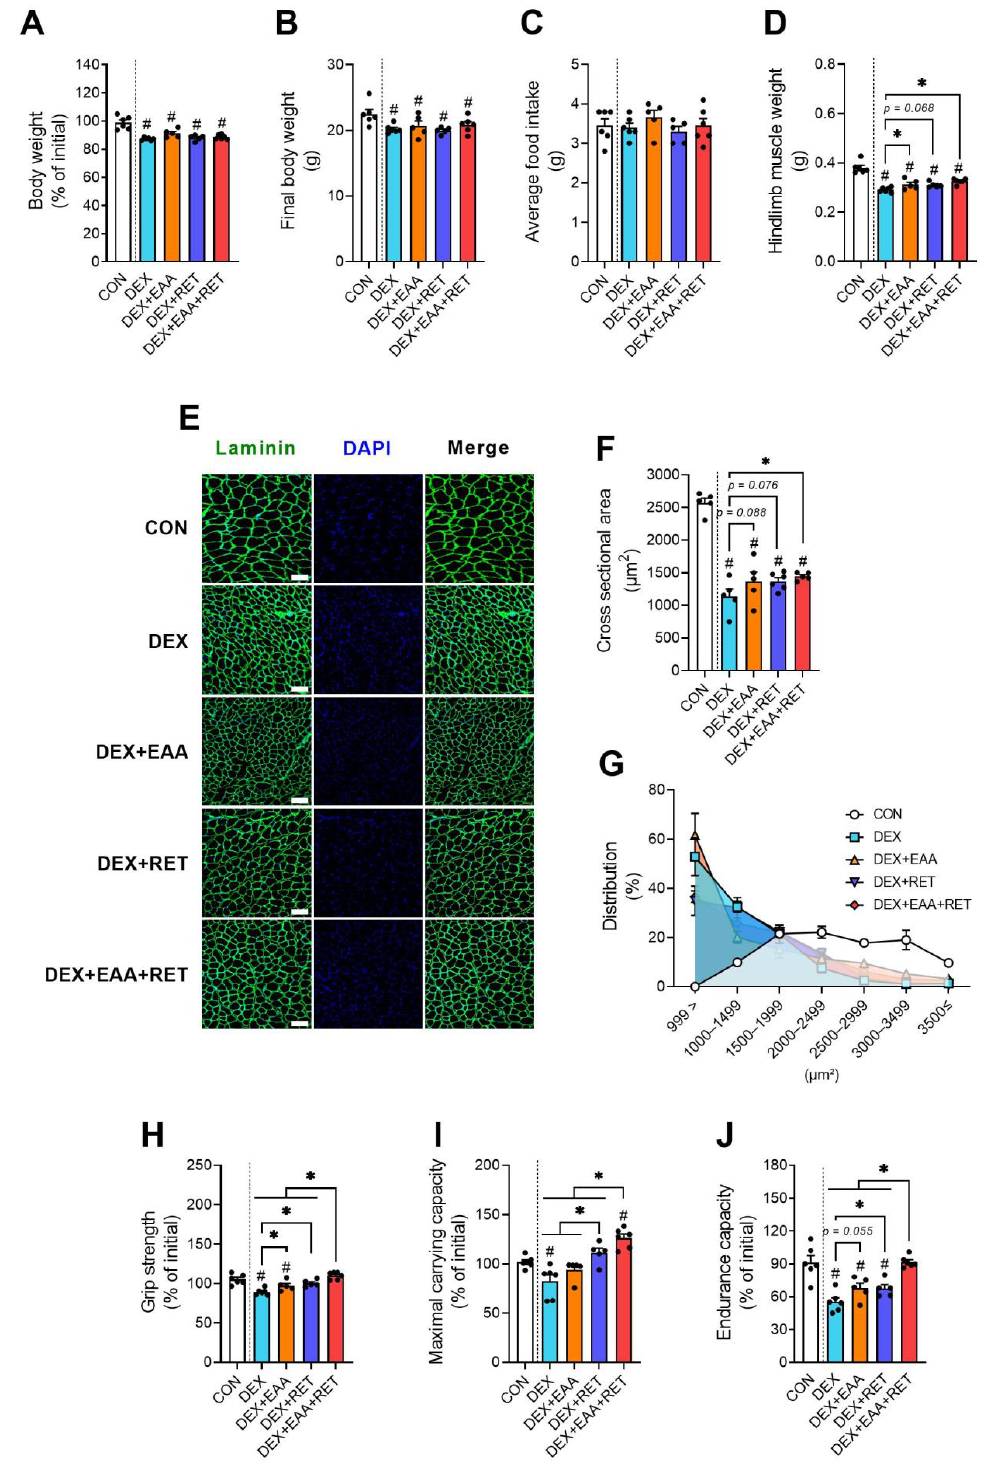
Figure 1. EAA and RET synergistically improve DEX-induced declines in muscle strength and endurance. ( A ) The changes in body weight after 14 days of each treatment (n = 5–6). ( B ) The